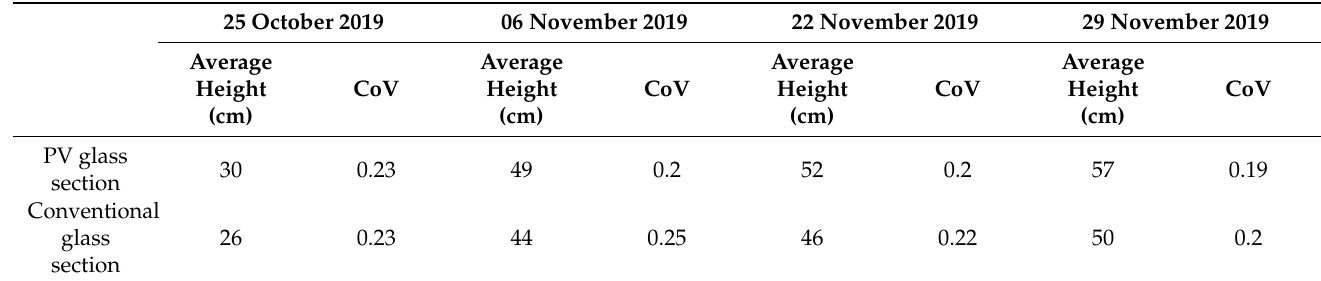
Table 3. Height of broad bean plants.